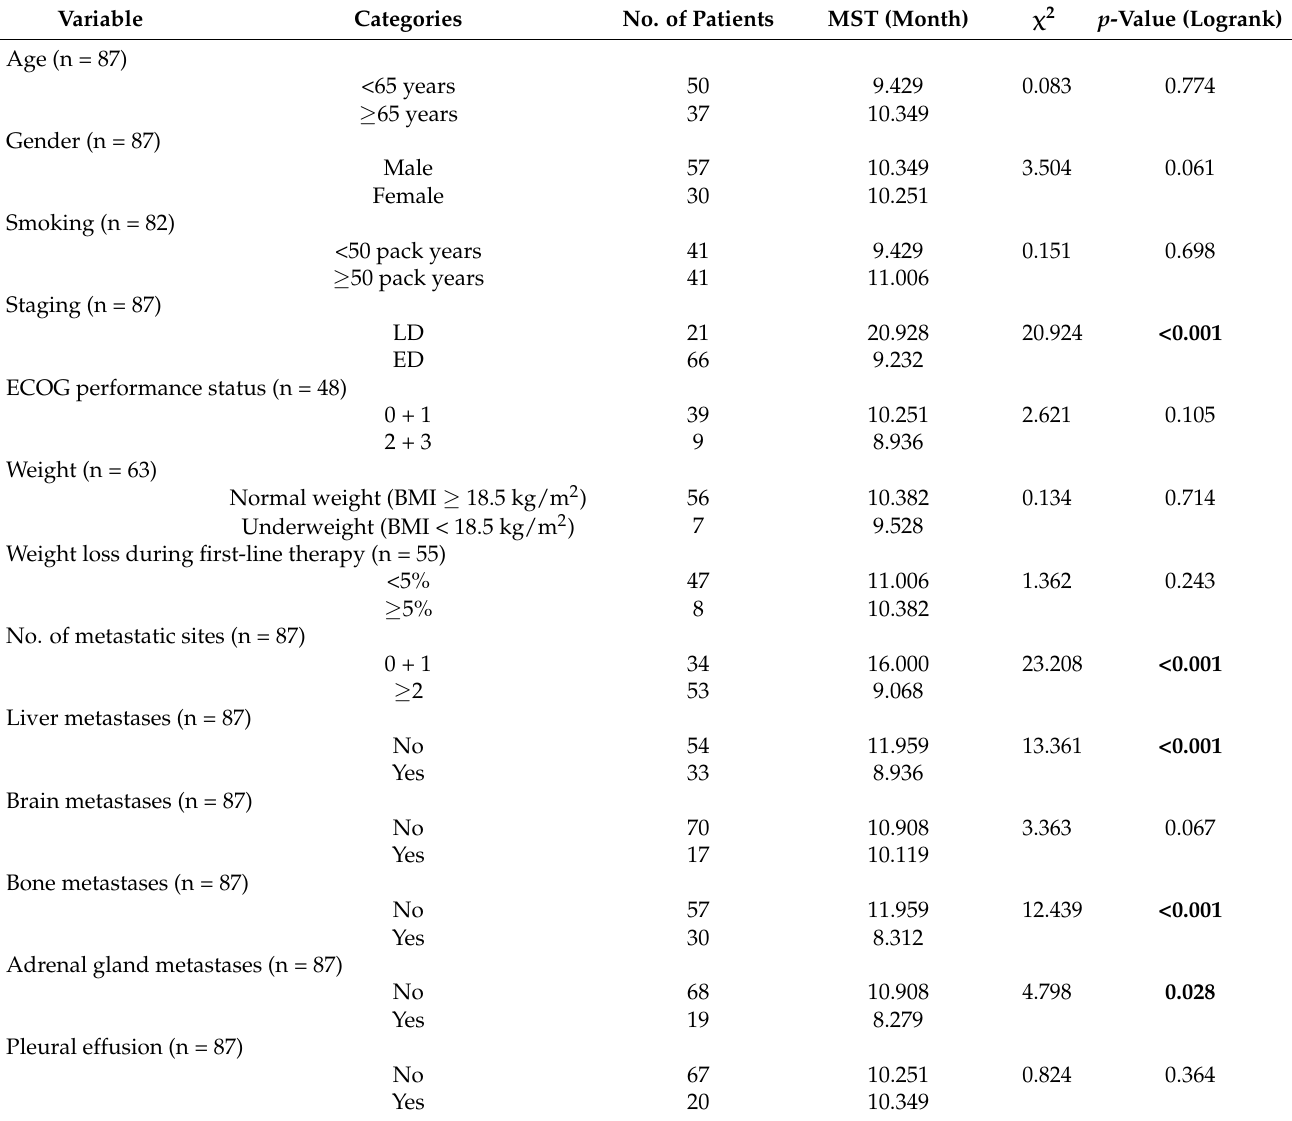
Table 1. Univariate analysis of clinical parameters at